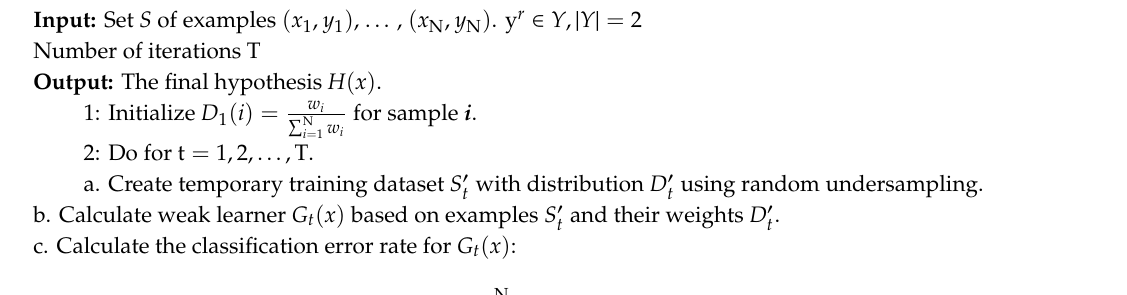
Algorithm A1. Training procedure of the proposed